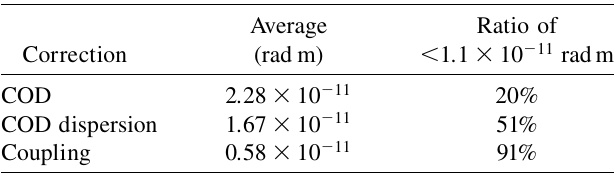
TABLE II. Simulated vertical emittance after each consecu- tive correction.